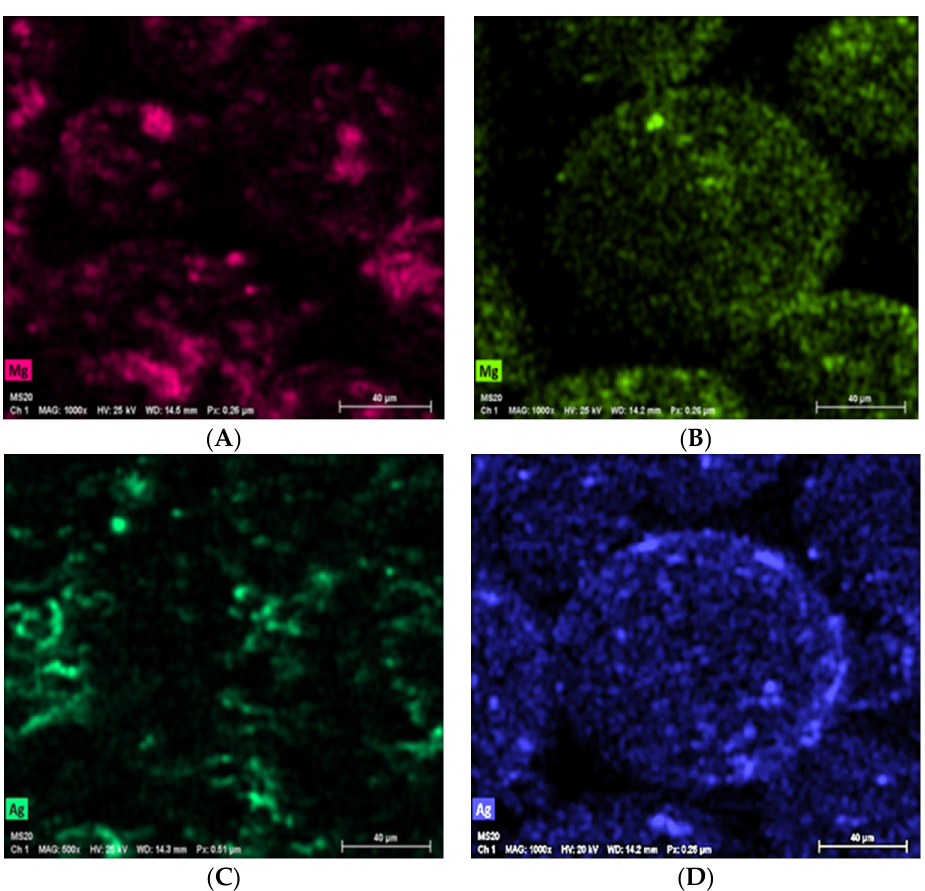
Figure 3. EDX photos of PMMA-MgO nanocomposite (( A ) non-ethanol-assisted and ( B ) ethanol-assisted) and PMMA-Ag nanocomposite powder (( C ) non-ethanol-assisted and ( D ) ethanol-assisted).